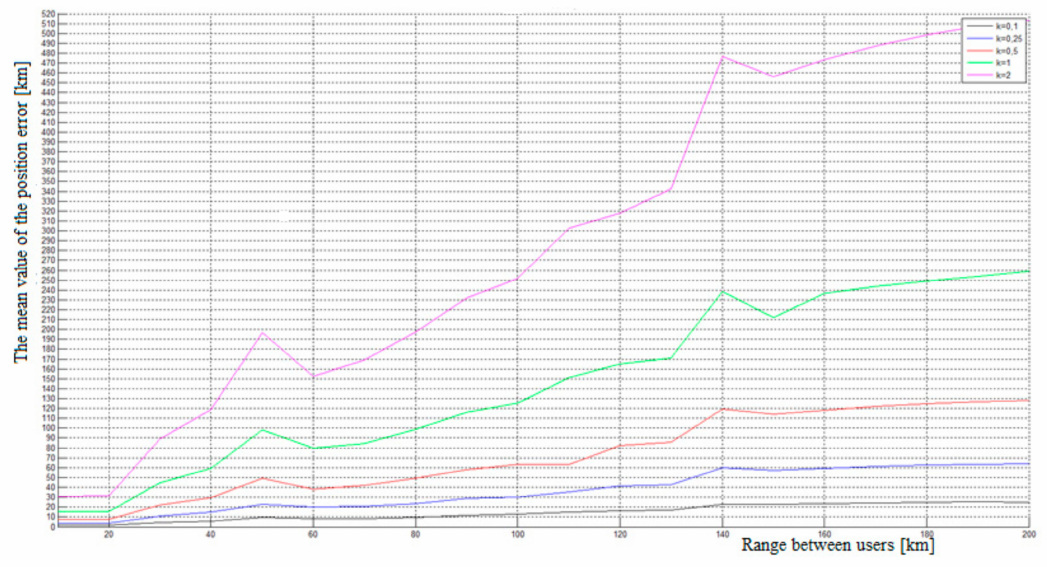
Figure 5. The comparison of position errors for various ranges of the pseudo-range